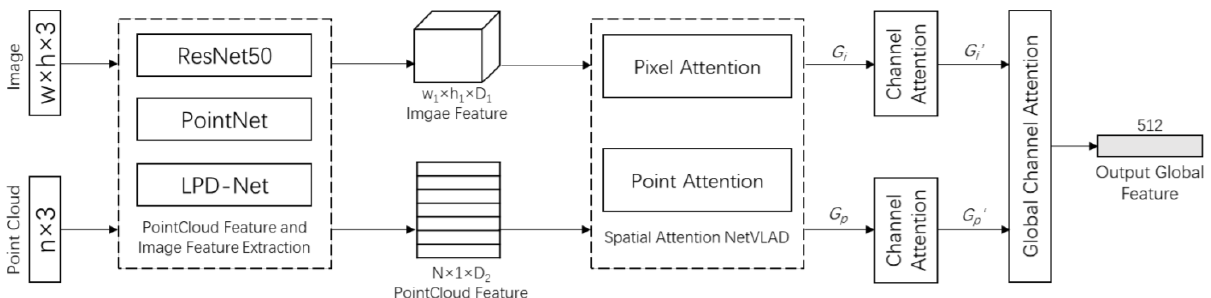
Figure 37. PIC-Net [89] composed of image and point cloud branch with spatial, channel, and global attention for large-scale place